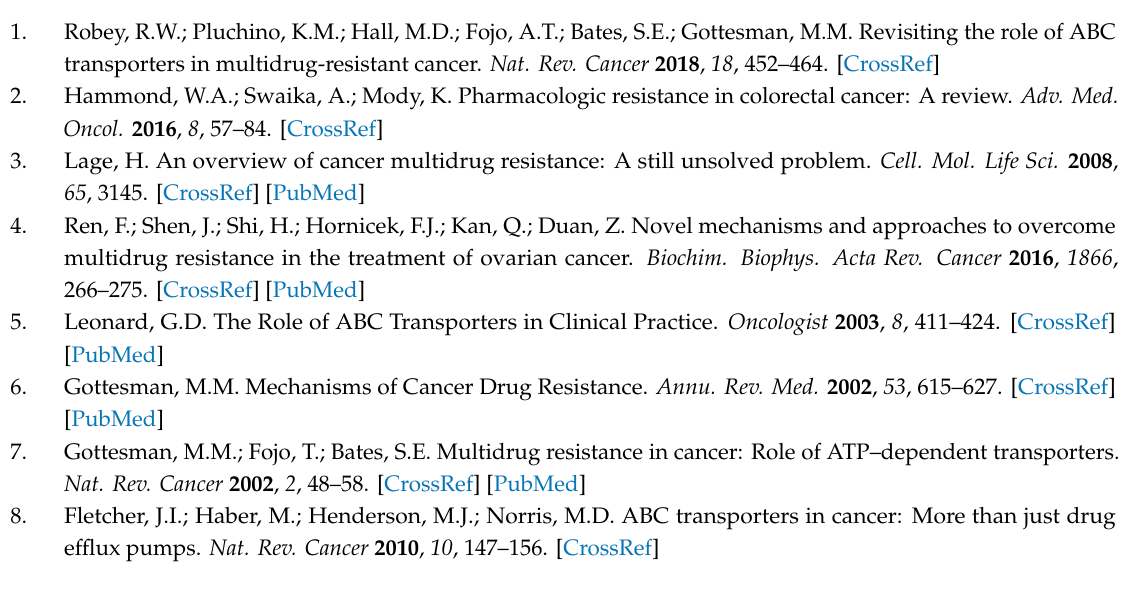
Figure S1: Western blot analysis of BCRP expression in SN-38-sensitive and SN-38-resistant HT29 cells. Figure S2: Cell viability assay with HT29 SN38-resistant colon cancer cells. Figure S3: Cell viability assay with mitoxantrone-resistant MDCK-II ATP-binding cassette (ABC)G2 cells. Figure S4: Cell viability assay with HT29 SN38-resistant colon cancer cells. Figure S5: Comparison of ABCG2 (BCRP) inhibition by SCO-201 and Ko143 as determined in the Hoechst 33,342 accumulation assay in MDCK cells. Figure S6: Comparison of SCO-201 and Ko143 as determined in the pheophorbide A accumulation assay in MDCK cells. Figure S7: SCO-201 (OBR-5-340)-mediated inhibition of BCRP. Figure S8: Timeline representation of interaction and contacts between residues in the binding cavity of the BCRP transporter and SCO-201. Figure S9: Timeline representation of interaction and contacts between residues in the binding cavity of the BCRP transporter and SN-38. Table S1: In vitro DMPK analysis of transporter inhibition. Table S2: In vitro DMPK analysis: CYP inhibition. Table S3: In vitro DMPK analysis: CYP